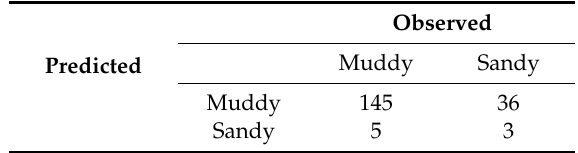
Table A10. Categorical muddy / sandy S-LOO CV error matrix.